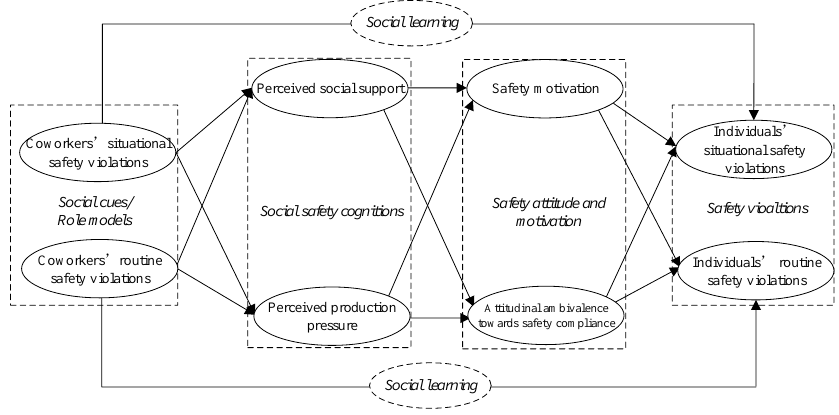
Figure 1. This study’s hypothesized model.